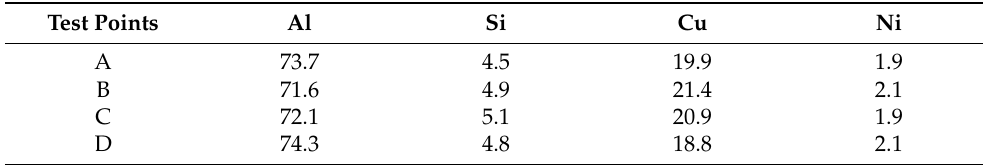
Figure 6. SEM micrograph of filler metal Al-5.0Si-20.5Cu-2.0Ni fabricated by melt-spinning technol- ogy: ( a ) SEM image; ( b ) Corresponding elemental mapping; ( c – f ) Individual elemental mapping of Al, Si, Cu, and Ni, respectively. Table 2. EDS results (wt.%) of points marked in Figure